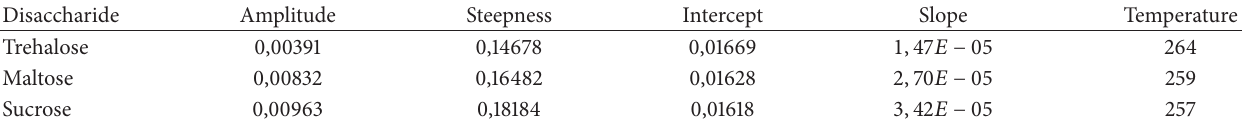
Table 1: Parameters of the fitting procedure according to (14) of the EINS intensity as a function of temperature for the three disaccharides. Disaccharide